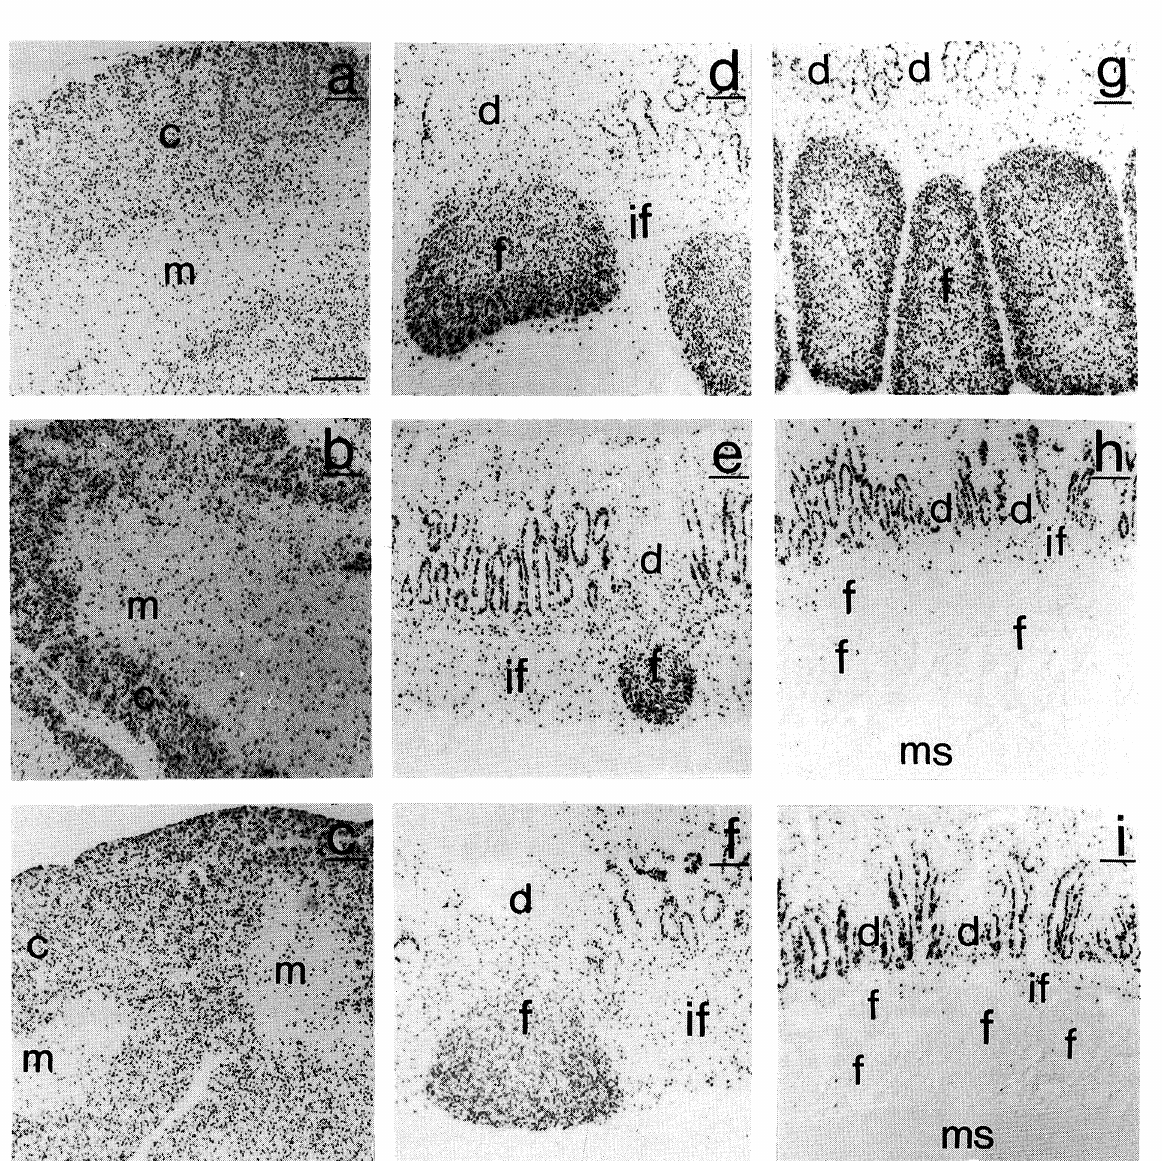
FIGURE 2. Cell proliferation, detected by BrdU incorporation, was analyzed in the thymus, jejunal PP, and ileal PP for age-matched, untreated lambs (control) and for lambs day (D.lpostdex) and 3 weeks (D.21postdex) after treatment for 7 days with 2 mg dexamethasone/kg BW. Thymus: a (control), b (D.lpostdex), and (D.21postdex) with the cortex (c) and medulla (m) indicated. BrdU incorporation was evident in the cortex both before and after dexamethasone treatment. Jejunal PP: d (control) and e (D.lpostdex), and f (D.21postdex) with the lymphoid follicles (f), dome region (d), and interfollicular area (if) indicated. BrdU incorporation was prominent in the crypt epithelium and lymphoid follicles both before and after dexamethasone treatment. Ileal PP: g (control), h (D.lpostdex), and (D.21postdex) with lymphoid follicles (f) dome region (d), interfollicular area (if), and muscularis (ms) indicated. No BrdU incorporation was detected within the follicles following dexamethasone treatment, but BrdU incorporation in the crypt epithelium remained unchanged. Magnification: a-i (bar [in a] 350